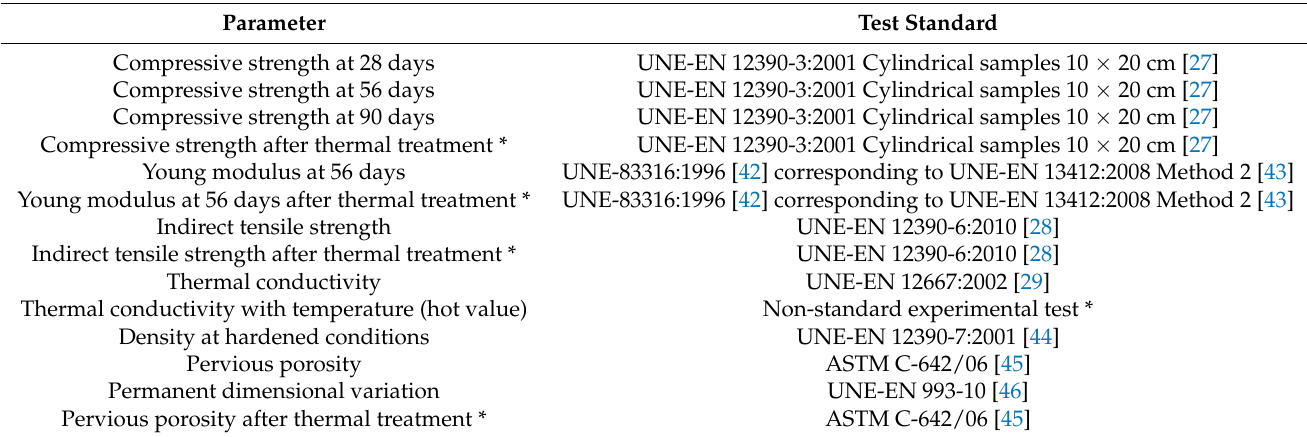
Table 6. Methods used for the characterization of the concrete